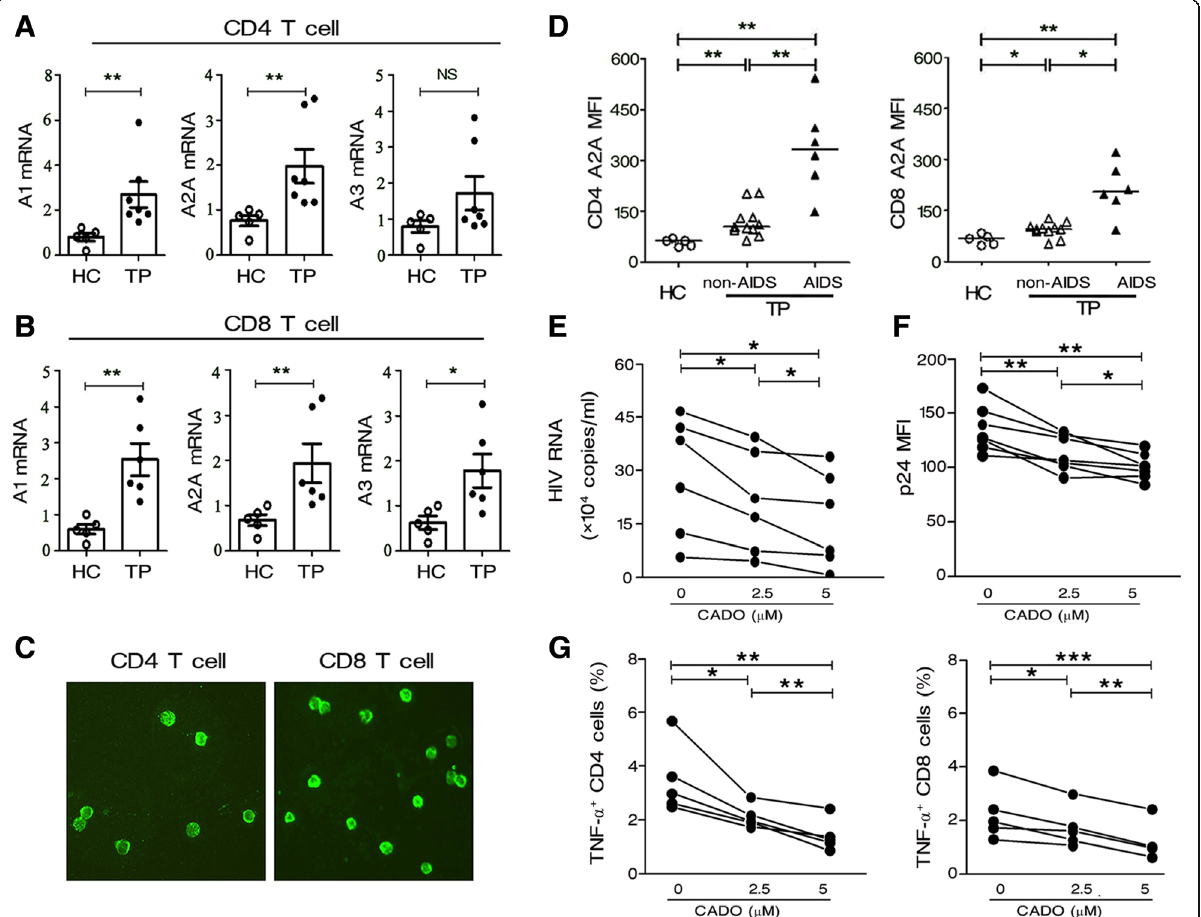
Fig. 6 The expression of adenosine receptors in T cells and inhibition of proinflammatory cytokine release and viral production by adenosine. RT- PCR results are shown for relative expression of A1R, A2AR, and A2BR in CD4 + ( a ) and CD8 + ( b ) T cells isolated from HCs (n = 5) and TPs (n = 7). c Immunofluorescence diagrams show that A2AR is constitutively expressed on CD4 + and CD8 + T cells. d MFI values of A2AR expressed on CD4 + and CD8 + T cells were higher in patients with AIDS. e PBMCs from TPs were stimulated with anti-CD3 and anti-CD28 antibodies. Virus titers were determined following 24 h of culture in the presence or absence of CADO. f MFI of the HIV-p24 + CD4 + T cells in gated HIV-p24 + CD4 + T cells in response to CADO under anti-CD3 and anti-CD28 stimulation. g Pooled data showing the TNF- α expressing CD4 + T cells and CD8 + T cells from TPs in response to various concentration of CADO under stimulation with anti-CD3 and anti-CD28 antibodies. * p < 0.05, ** p < 0.01, *** p <